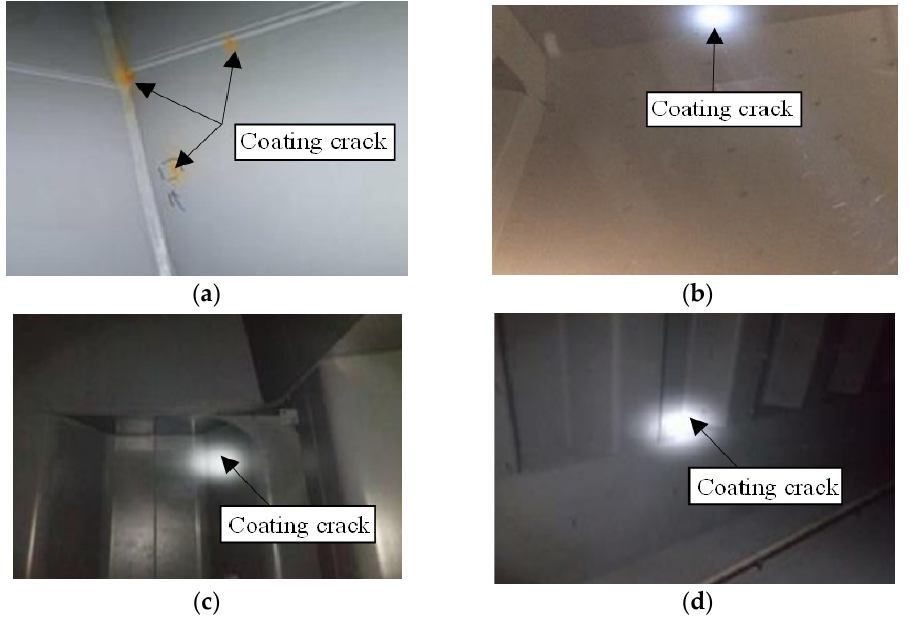
Figure 3. Coating crack survey results in the cargo hold: ( a ) low stool; ( b ) typical web section deck; ( c ) upper stool (bottom); ( d ) lower stool (bottom).